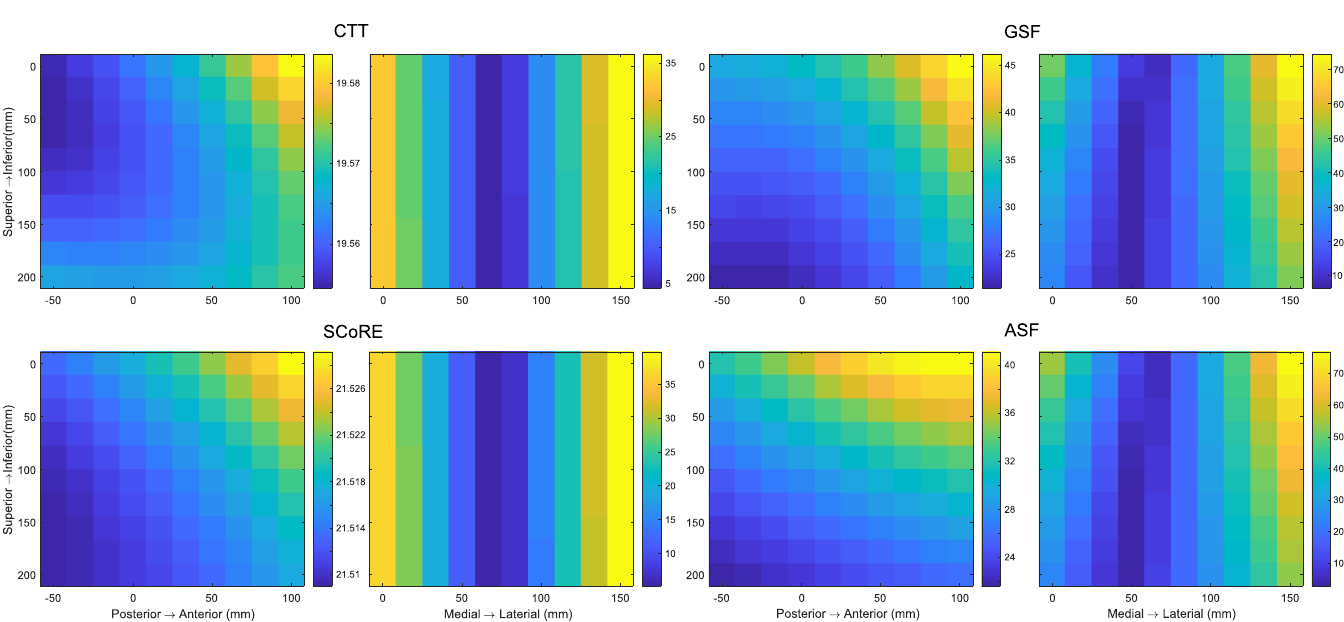
Fig 4. Error distribution of the proximal coordinate origin varying in the frontal and transverse planes when four different functional methods were applied. The origin of the proximal coordinate system was varied with increment steps of 10 mm and ranged from 0 to 150 mm along medial-lateral axis, from -50 to 100 mm along the posterior-anterior axis and from 0 to 2000 along the inferior-superior axis.